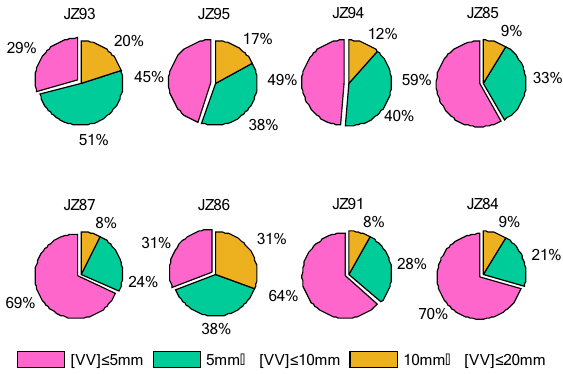
Figure 7 Comparison of Proportion of Different